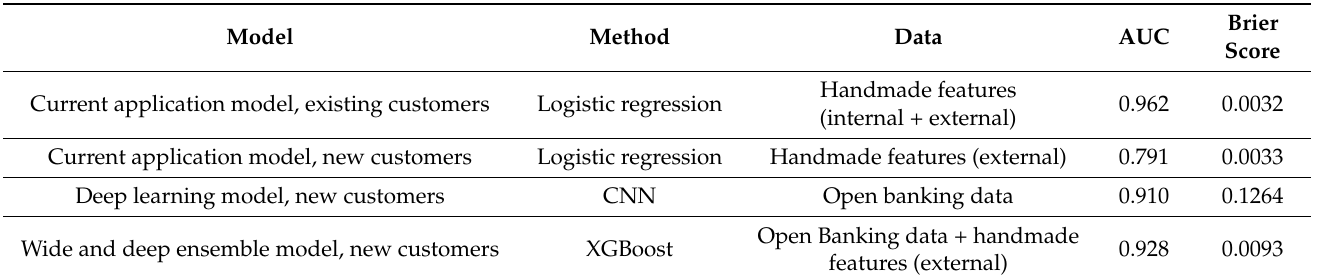
Table 5. Model performance (AUC and Brier score), large test sample, 15,360 obs.